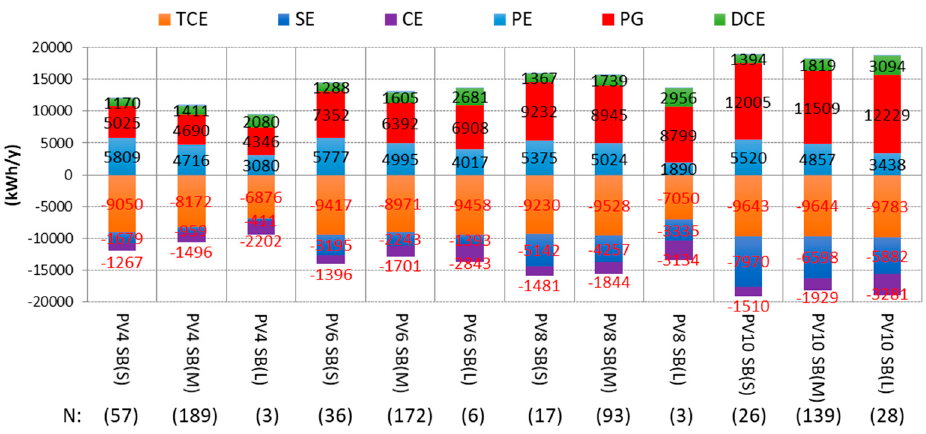
Figure 6. Annual power balance for PV and storage batteries (SB).